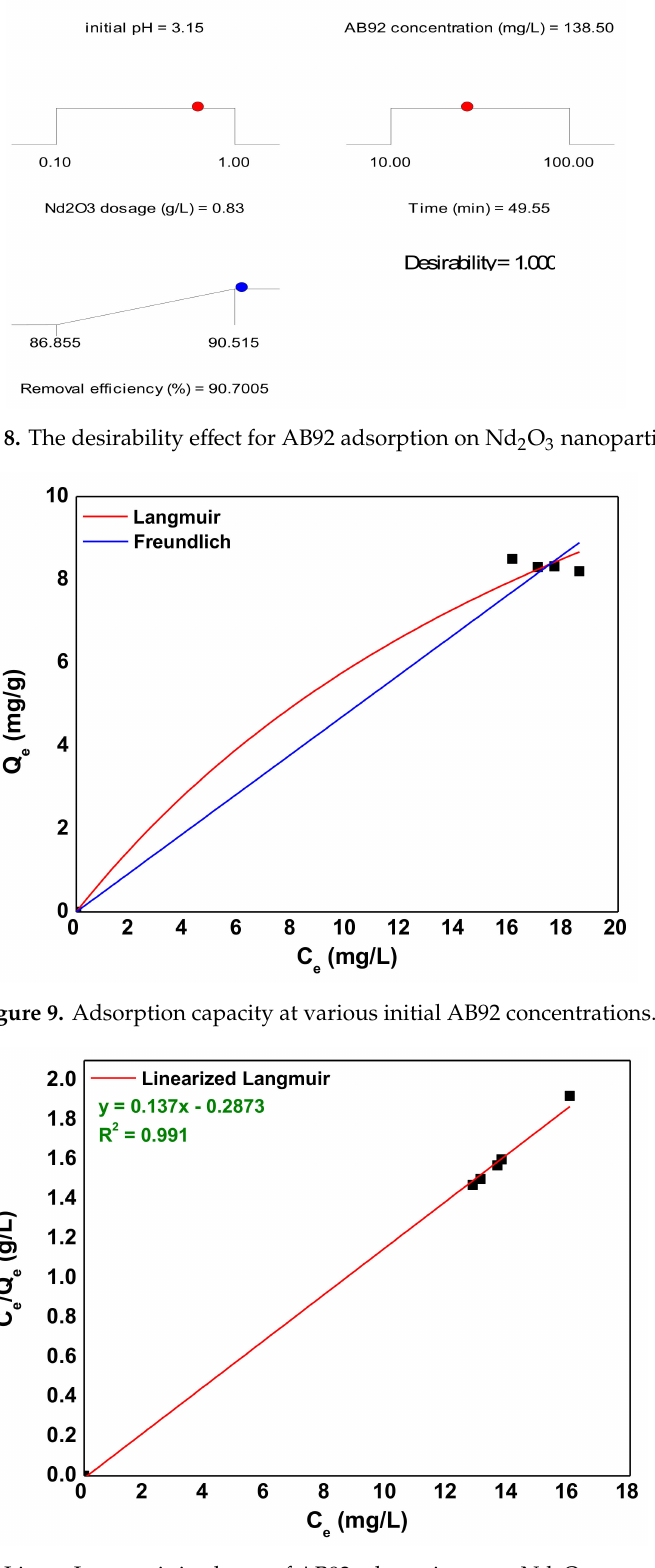
Figure 10. Linear Langmuir isotherm of AB92 adsorption onto Nd 2 O 3